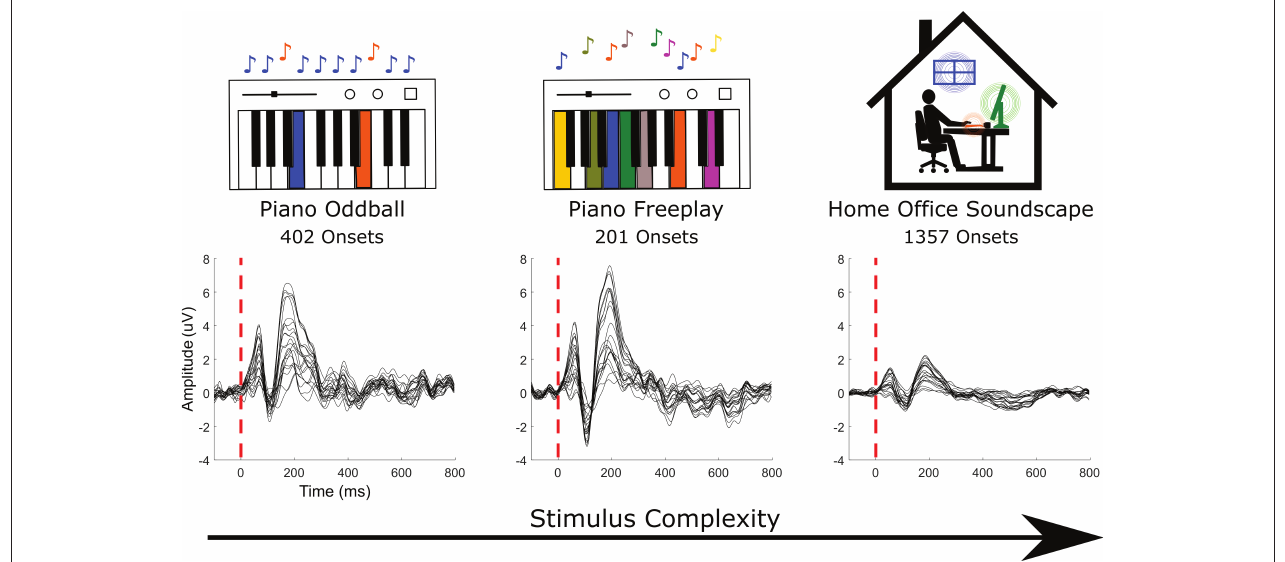
FIGURE 3 | Grand average event-related potentials (ERPs) of all channels in the EEG recorded in response to the random sequence of two tones (piano oddball, 402 onsets), the random sequences of multiple tones (piano freeplay, 201), and to home-office soundscape events